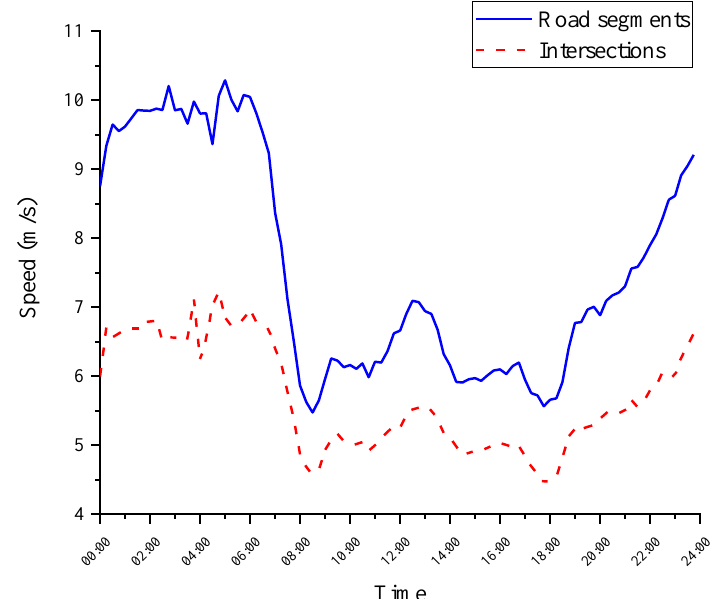
Figure 2. Average speed at intersections and in road segments.